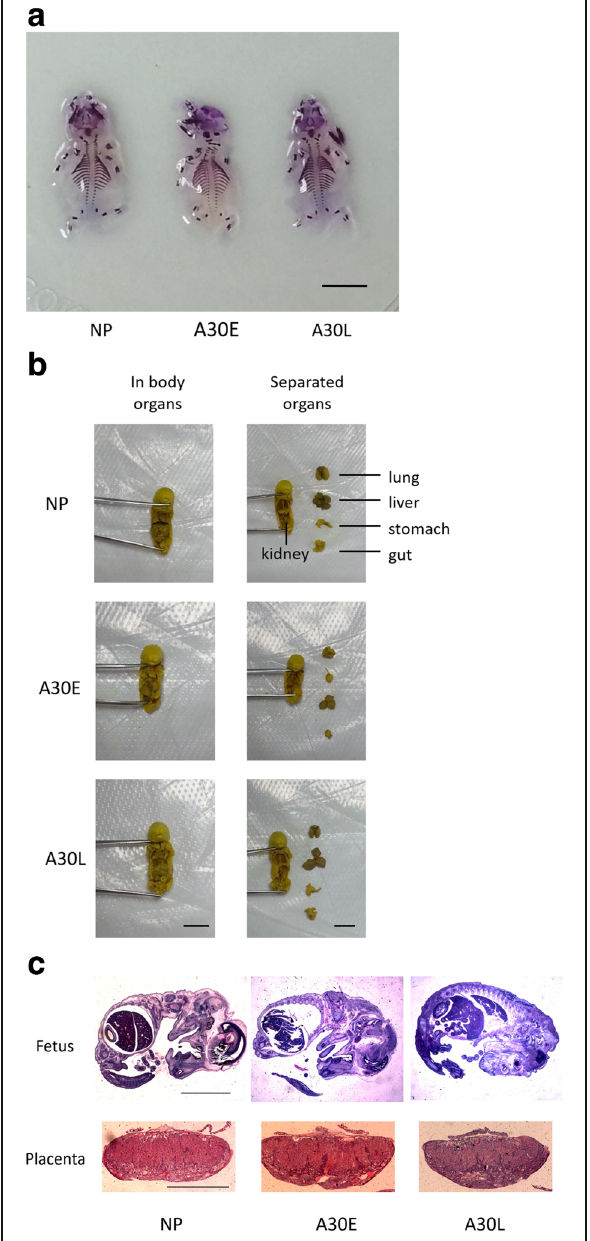
Fig. 3 Development of non-aborted, viable fetuses in each group. a Skeletal development of E16.5 fetuses. Scale bar is 1 cm. b Visceral development of E16.5 fetuses. Scale bar is 1 cm. c H&E staining of E16.5 fetuses and PAS staining of E16.5 placental tissues. Representative images of at least 4 samples for each group are shown. Scale bar are 1 cm (fetus) and 0.5 cm